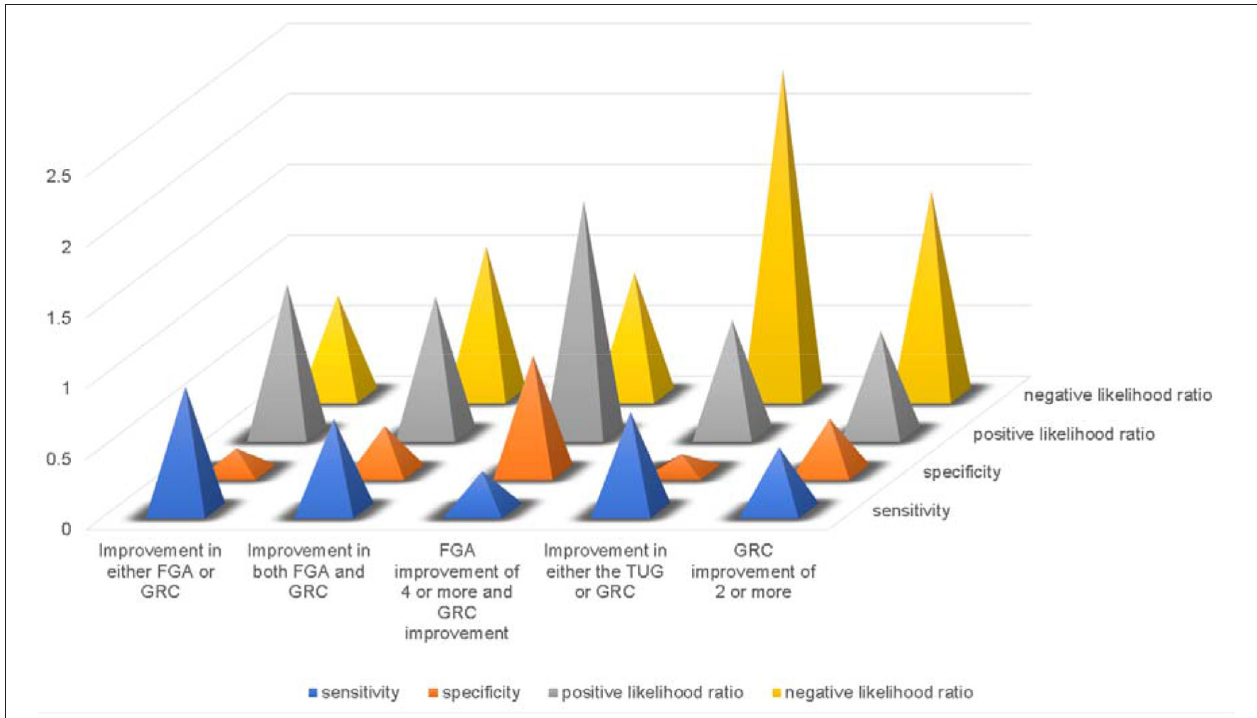
FIGURE 1 | Comparison of evaluation methods for the effectiveness of the tap